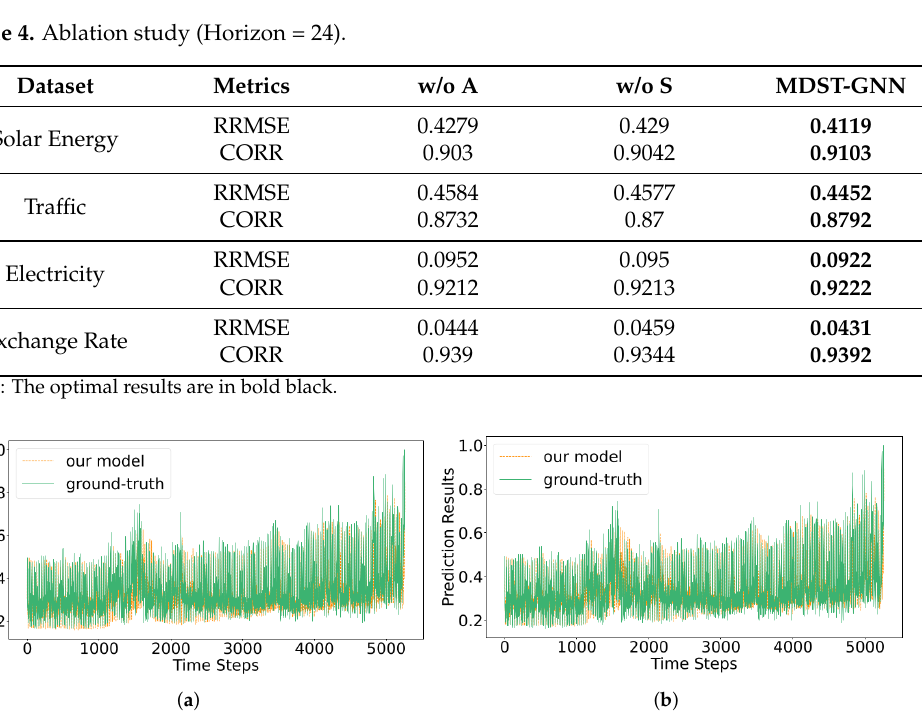
Figure 13. Time series (one variable) predicted and true values for the Electricity test set (Horizon = 24). Left ( a ) is the w/o S model result, right ( b ) is the result of the full